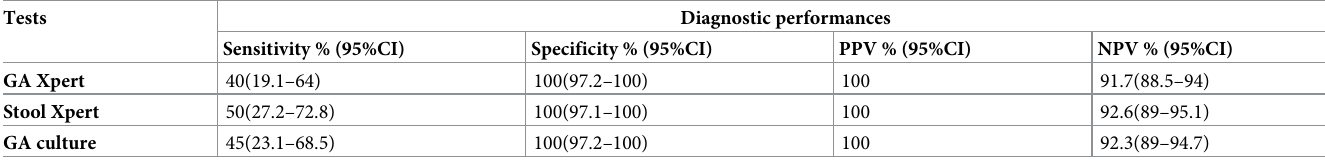
Table 5. The diagnostic performance of GA Xpert, stool Xpert and GA culture compared to